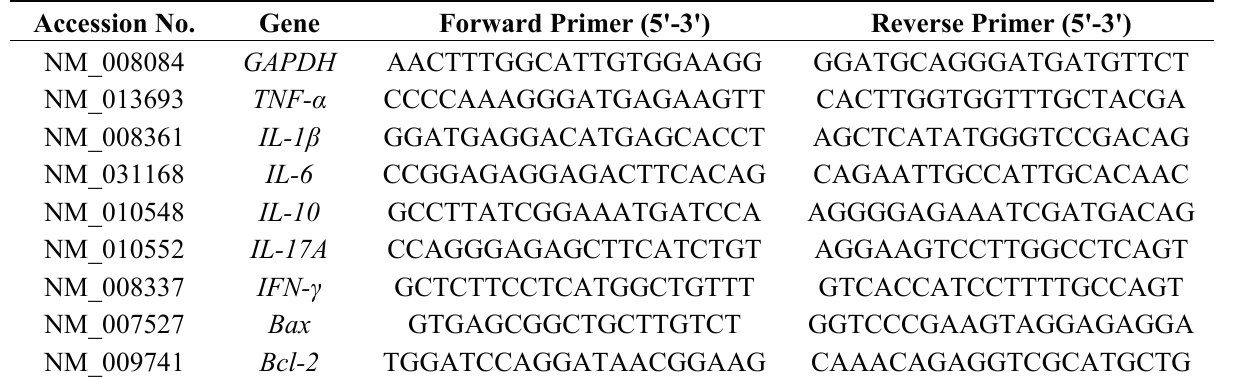
Table 1. Mouse primer pairs used for real-time